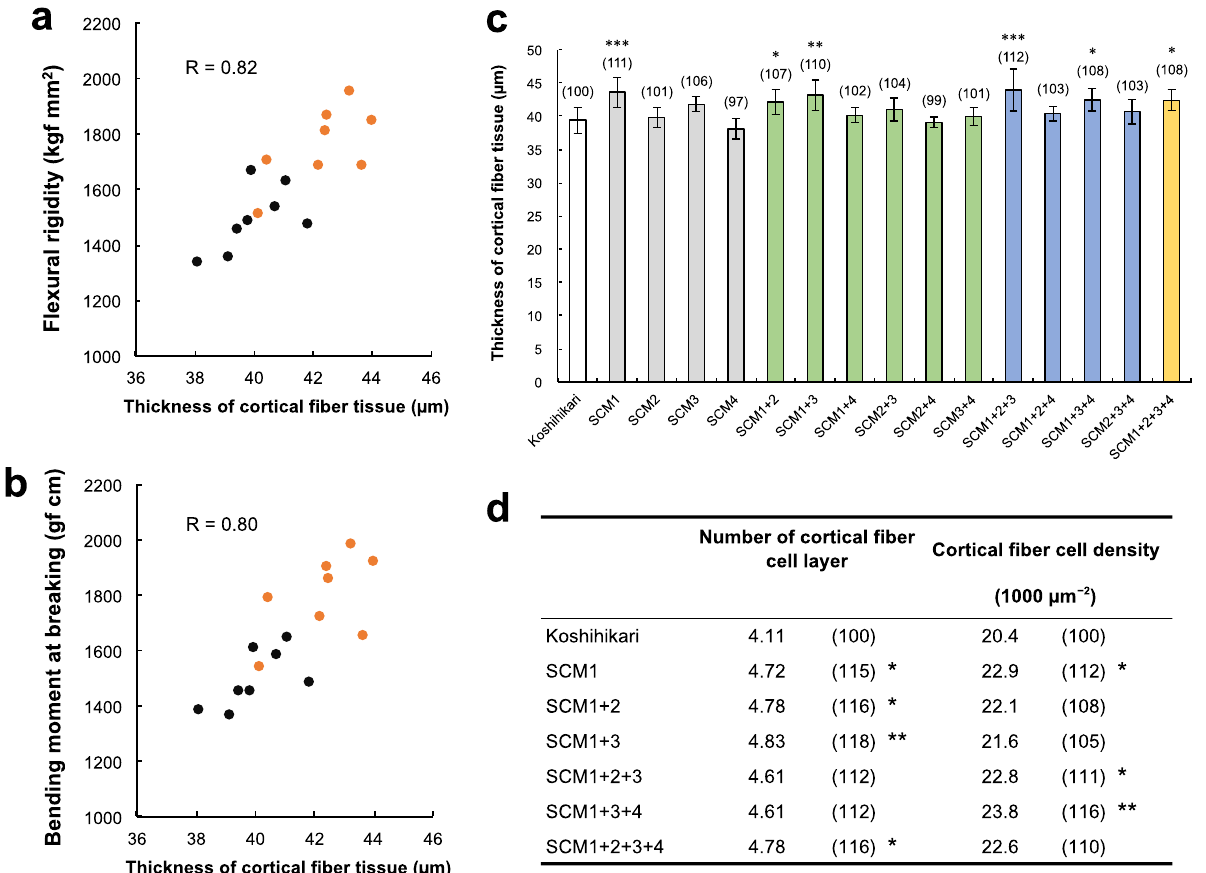
Figure 6. The relationship between culm strength and cortical fiber tissue thickness, and a comparison of structural properties in cortical fiber tissue among pyramiding lines. ( a ) The relationship between Flexural rigidity and cortical thickness. Orange circles indicate the lines including SCM1. ( b ) The relationship between bending moment at breaking and cortical thickness. The numbers in parentheses show values relative to Koshihikari (100). ( c ) Comparison of cortical fiber tissue thickness in Koshihikari and pyramiding lines. ( d ) The number of cortical fiber cell layers and cortical fiber cell density in Koshihikari and pyramiding lines. The numbers in parentheses show the values relative to Koshihikari (100). *, ** and *** indicate significant differences compared to Koshihikari at the 5%, 1% and 0.1% level (Dunnett’s